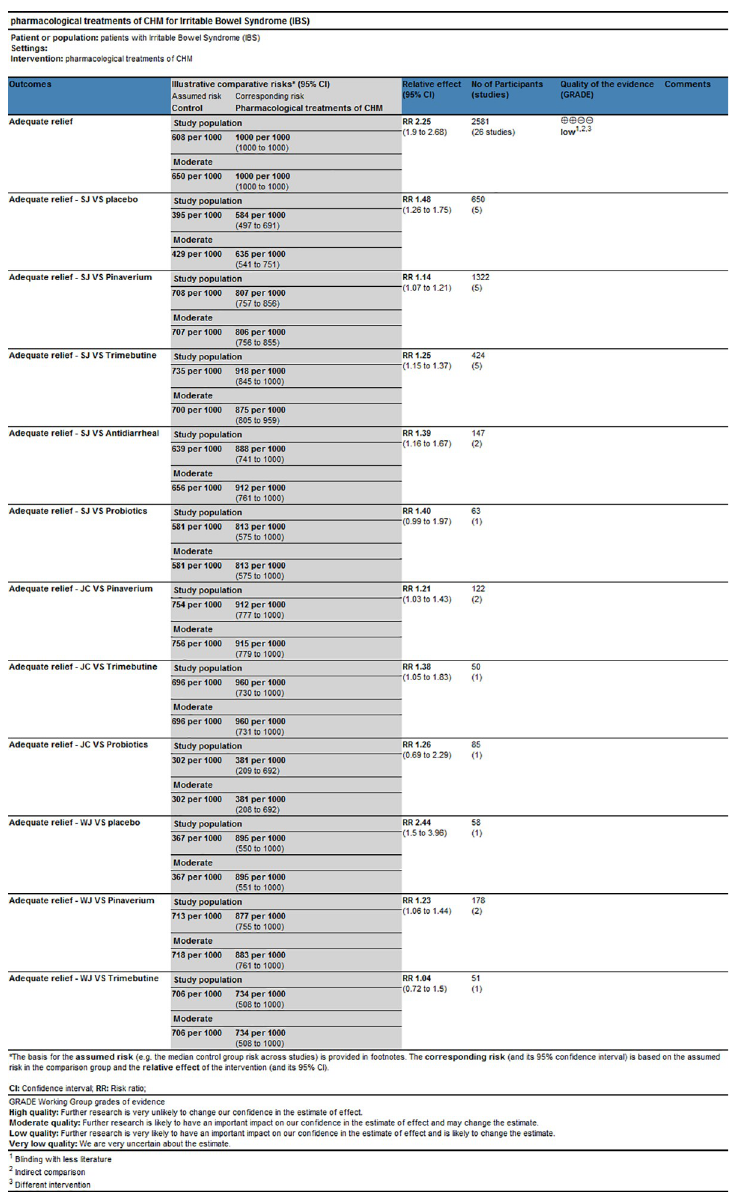
Fig 10. Grading of recommendations assessment, development and evaluation quality grading